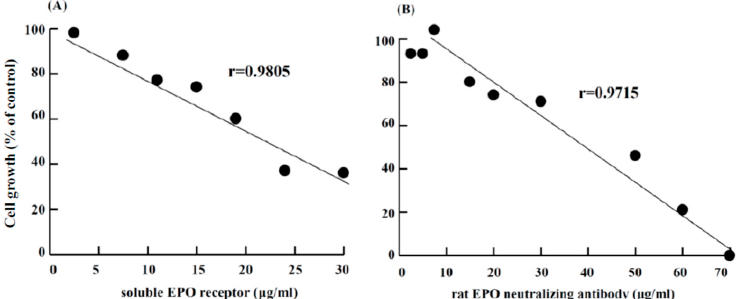
Figure 7. Effect of the soluble EPO receptor or rat EPO-neutralizing antibody on ZnCl 2 -induced erythropoiesis. Rat bone marrow cells were suspension-cultured with 0.3 mM ZnCl 2 and supplemented with different concentrations of ( A ) soluble EPO receptor or ( B ) rat EPO-neutralizing antibody. After one day, the harvested cells were measured to determine the cell size and number. The cell growth is expressed as the ratio of the number of 5.1 μ m cells at the start of the culture compared with that of the control.